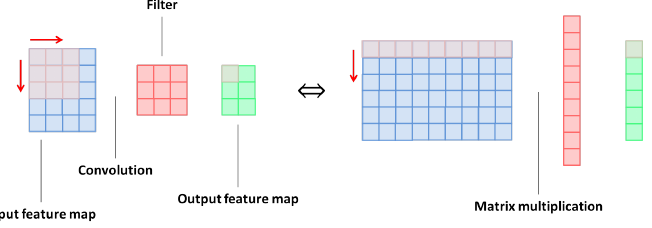
Figure 4. The convolution operation can be regarded as an element-wise multiplication of the convolutional filter with its corresponding local window in the input feature